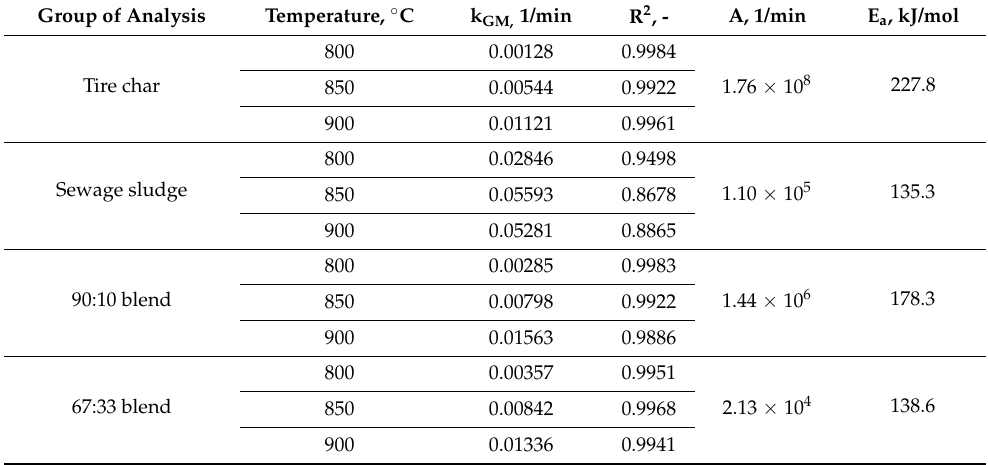
Table 4. Kinetic parameters of steam